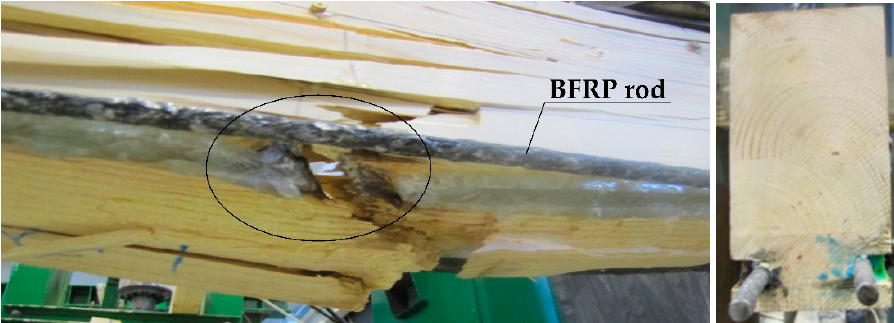
Figure 12. Image of the Wa-A2 beam destruction (photograph by Wdowiak).